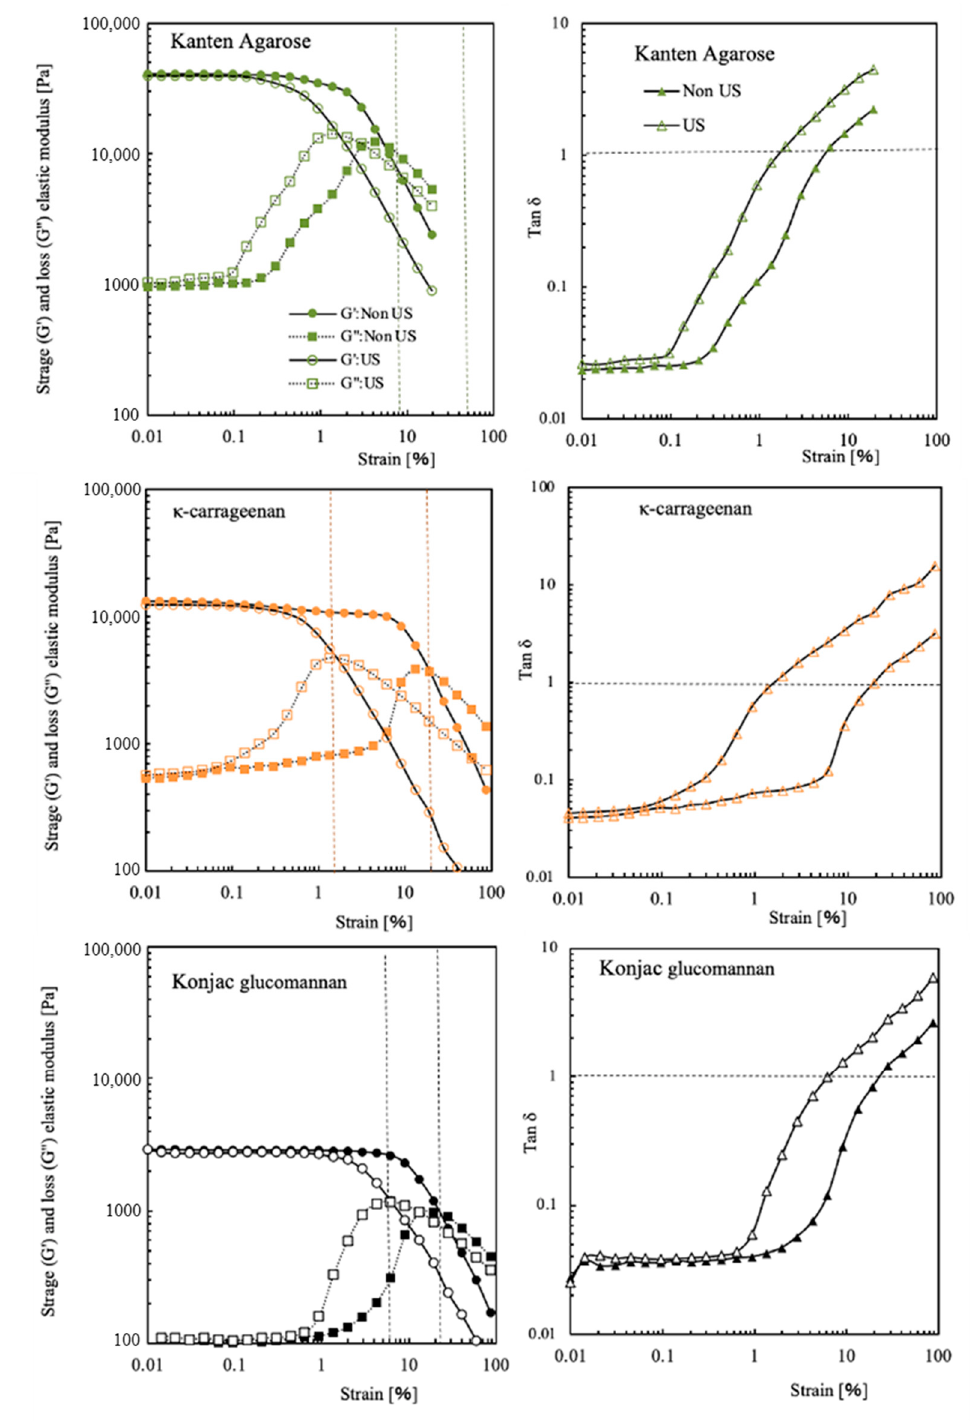
Figure 2. G (cid:48) and G” moduli and tan δ of Kanten agarose, κ -carrageenan, and konjac glucoman- nan hydrogels at different strain% in the absence (closed symbol) and presence of US exposure (opened